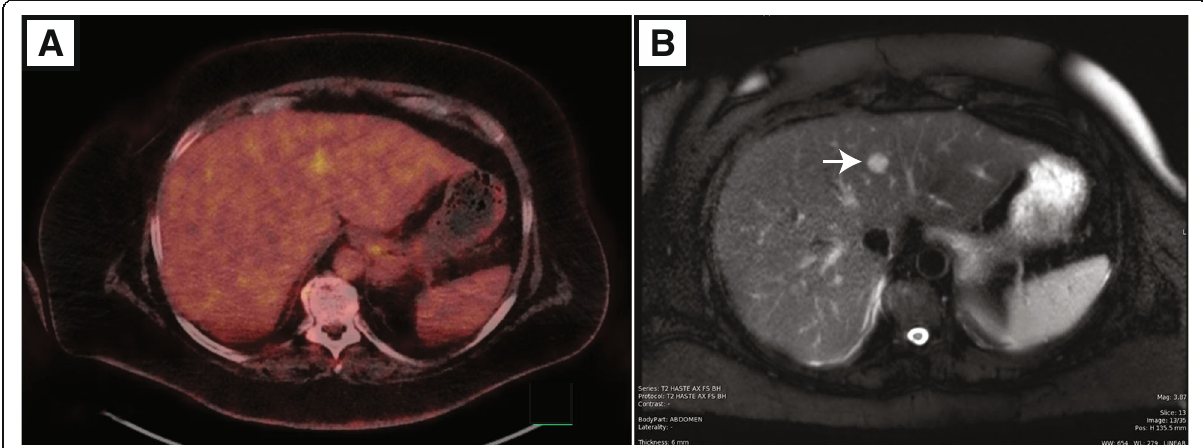
Fig. 4 Imaging of the liver lesion. PET-CT ( a ) showed heterogenous liver uptake with a focus in the medial left lobe. T2-weighted MRI ( b ) confirmed a discrete 1.8 cm lesion suspicious for metastasis ( arrow ). This was later confirmed by